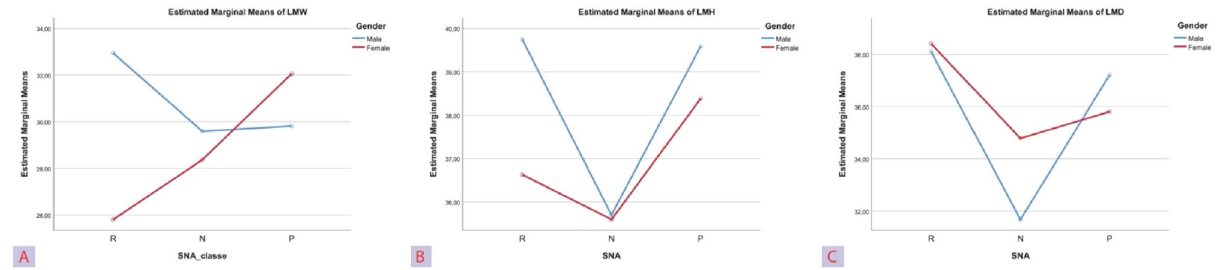
Figure 6. The plots of respectively the mean LMW ( A ), LMH ( B ), LMD ( C ) measurements for each combination of groups of Gender and SNA are plotted in a line